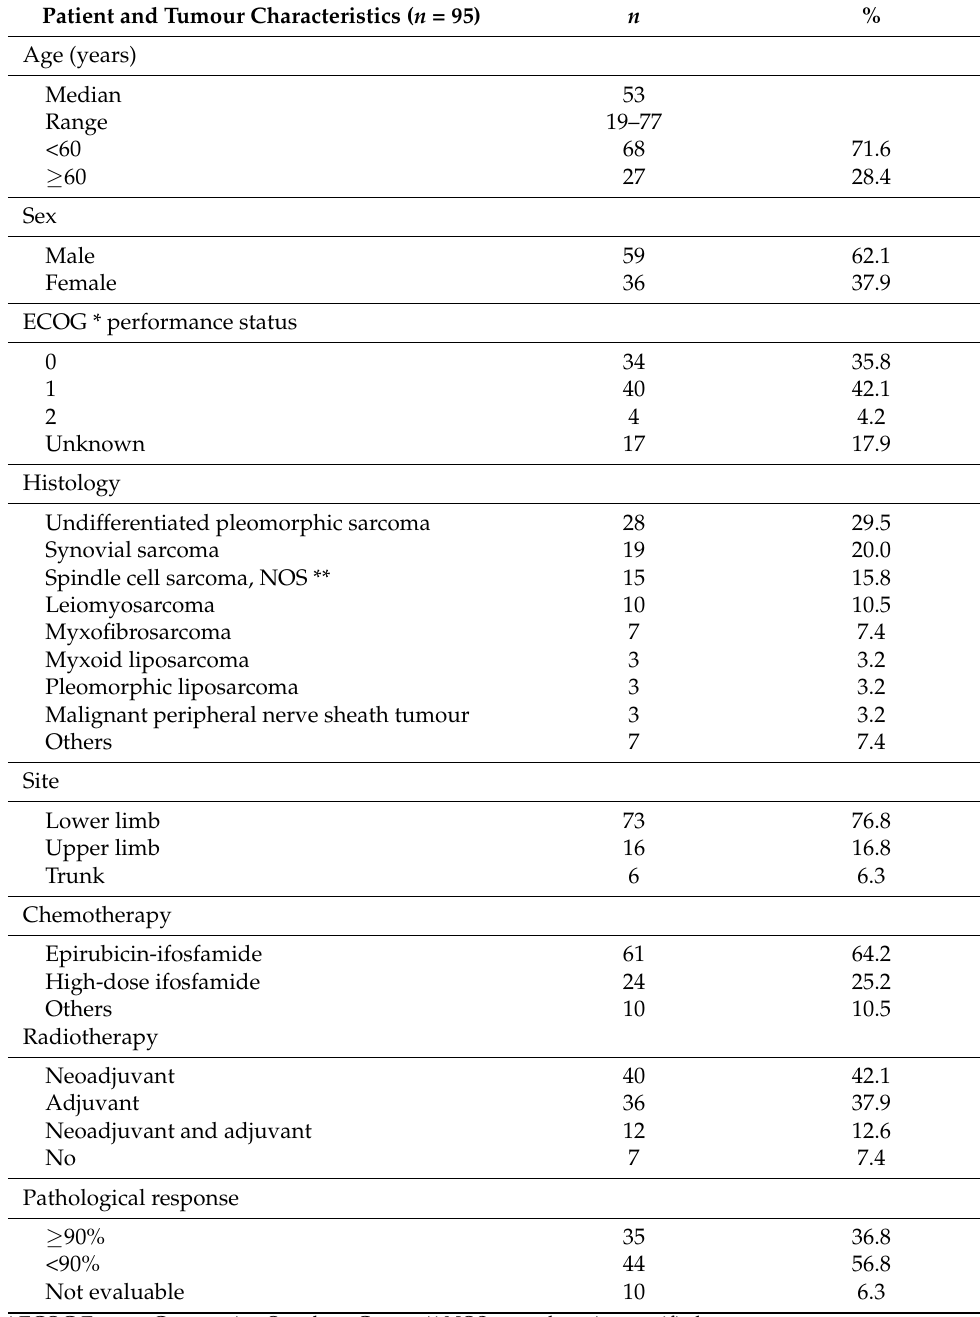
Table 1. Demographic and clinicopathological characteristics of high-risk soft tissue sarcoma patients ( n =